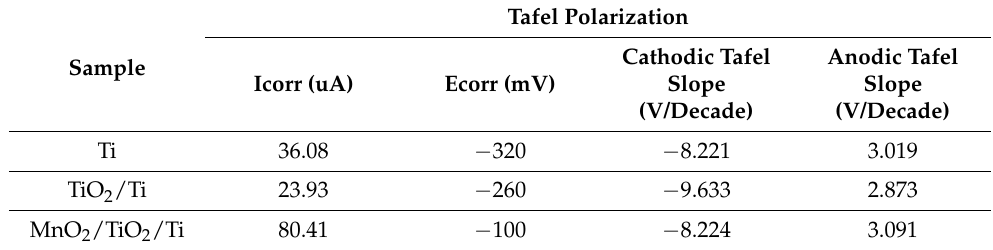
Figure 4. Tafel test results of metal porous Ti, surface−modified TiO 2 /Ti, and MnO 2 /TiO 2 /Ti nanocomposites. Table 1. Results of the Tafel texts of the porous Ti, surface-modified TiO 2 /Ti, and MnO 2 /TiO 2 /Ti nano